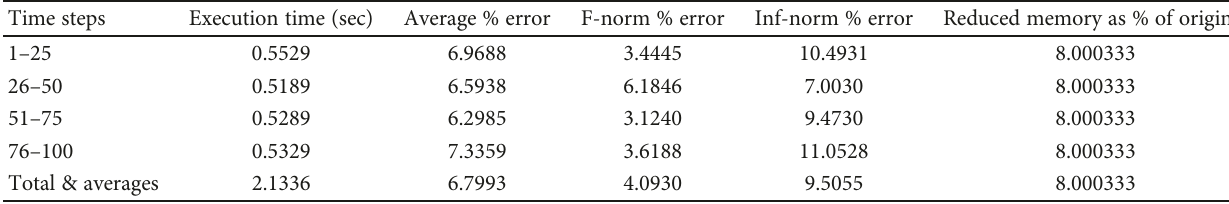
Table 16: 3D reduced model of density over four sets of 25 time